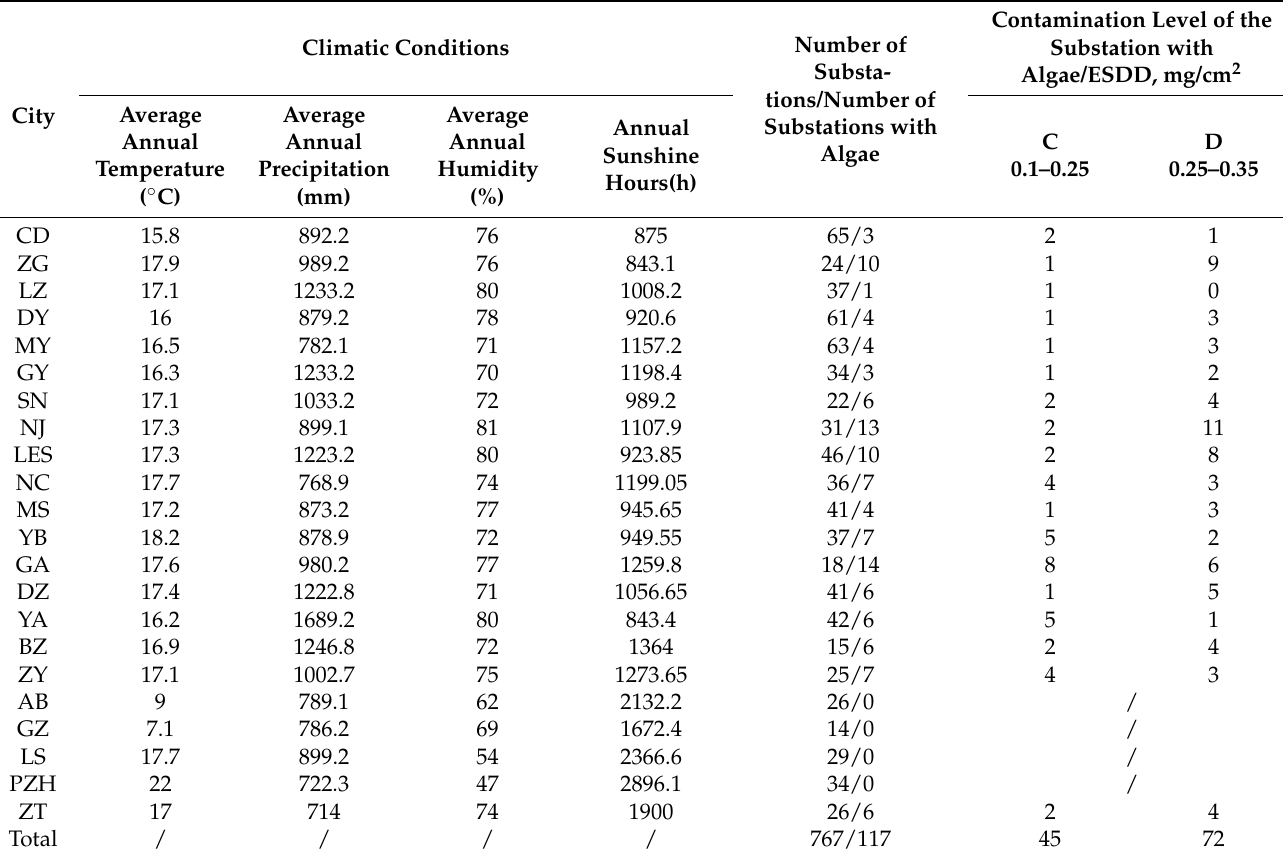
Table 1. Statistics on the growth of algae in Province